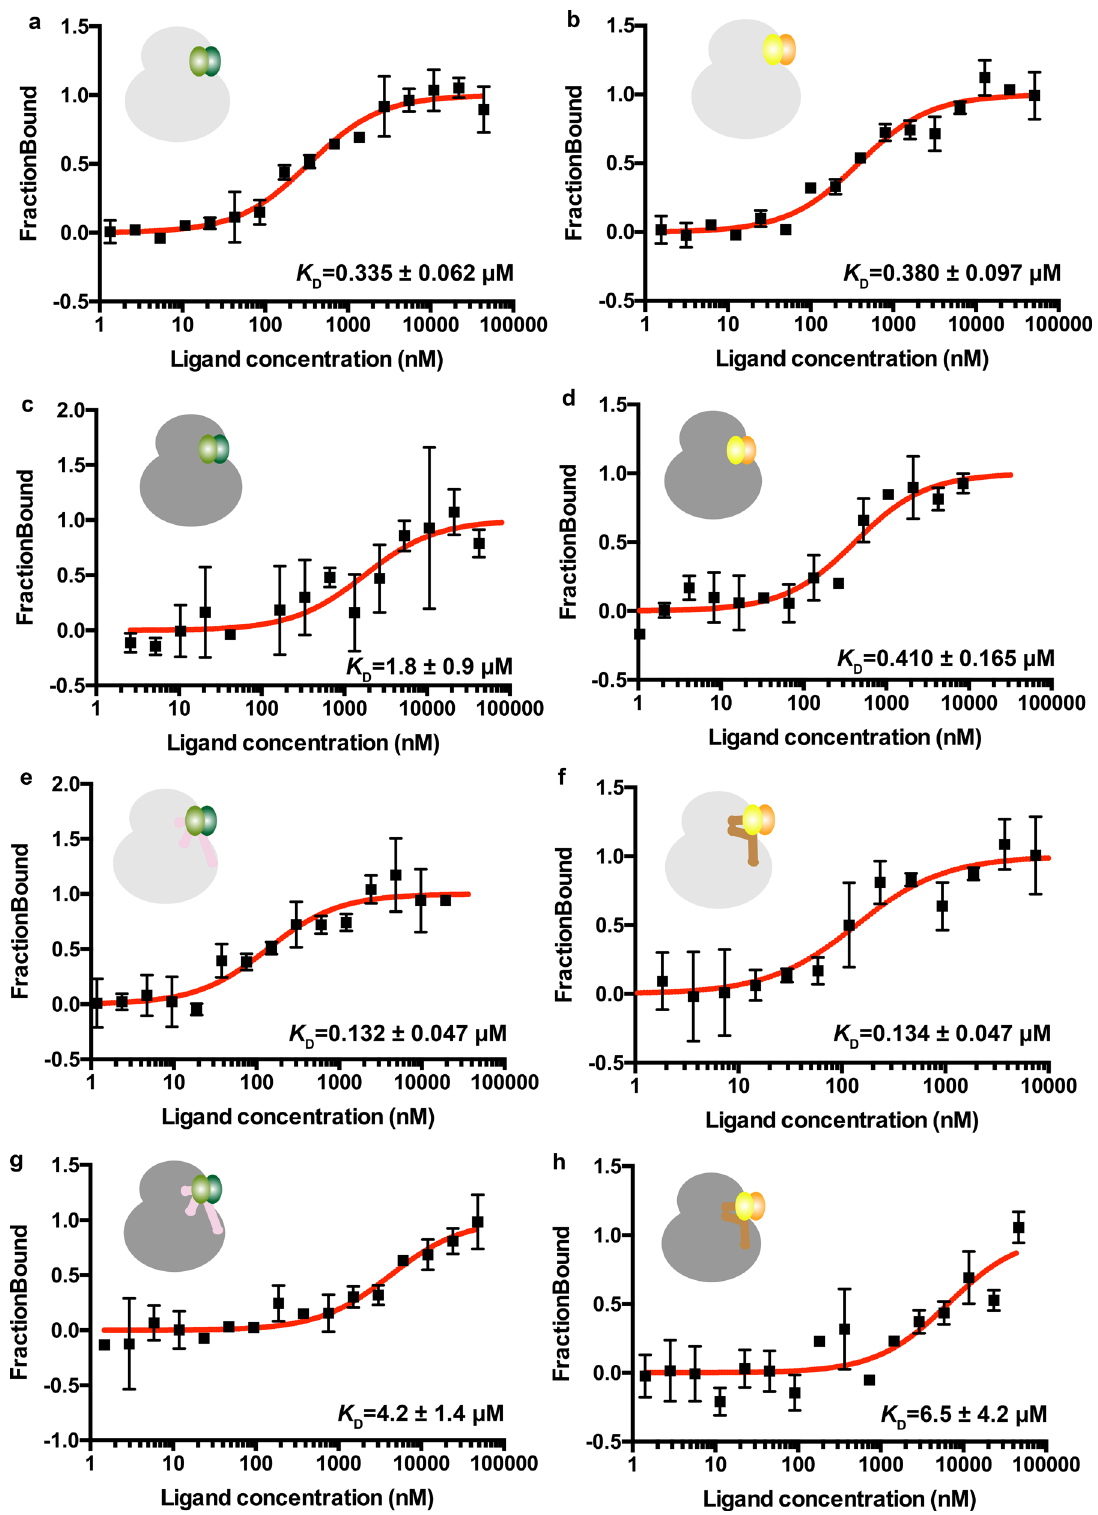
Fig. 7 MST data for SRP9/14 and Alu domain binding to 80S ribosomes. Pf SRP9/14 and Hs SRP9/14 heterodimers are shown in light – dark green and yellow – orange, respectively. Pf 80S ribosomes are shown in light gray, whereas Hs 80S ribosomes are shown in dark gray. a The Pf SRP9/14 heterodimer binds to Pf 80S ribosomes with high af fi nity. b Hs SRP9/14 binds to Pf 80S ribosomes with slightly lower af fi nity. c , d Pf SRP9/14 binds to Hs 80S ribosomes with substantially lower af fi nity than Hs SRP9/14. e Pf Alu or f Hs Alu domains bind to Pf 80S ribosomes with similar high af fi nity. g Pf Alu or h Hs Alu domains bind to the Hs 80S ribosomes with ~30- to 50-fold weaker af fi nity compared to Pf 80S ribosomes ( e , f ). Average values for at least two replicates are shown and error bars represent the standard deviation ( n ≥